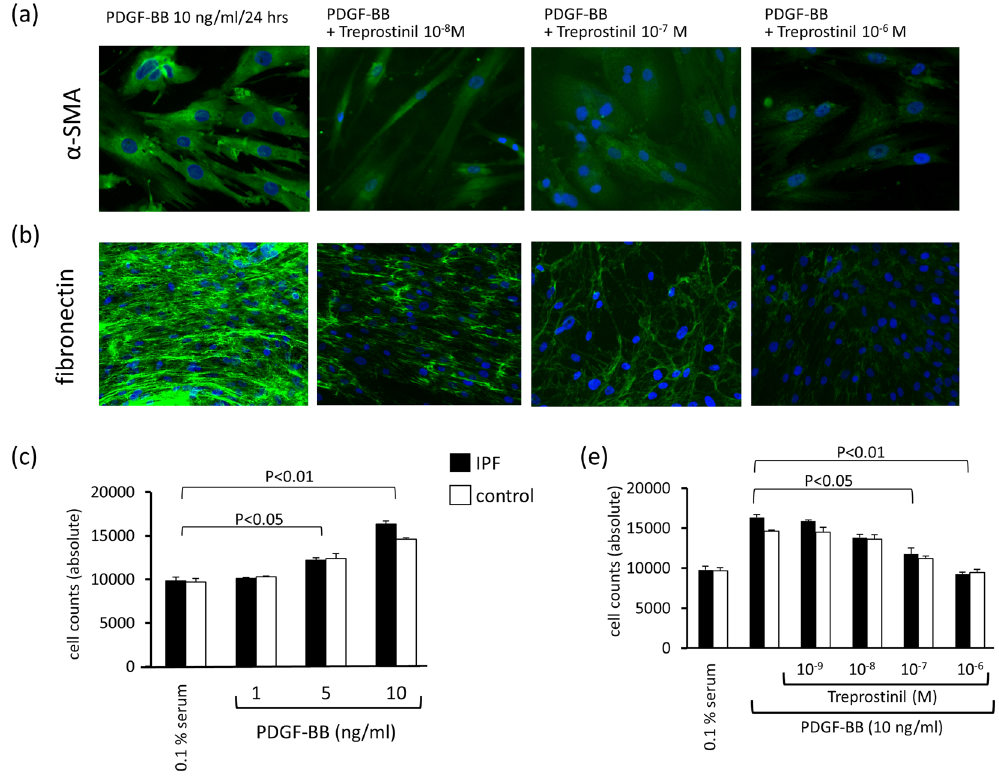
Figure 6. ( a ) Representative cyto-chemical staining (n = 3) for the dose-dependent reduction of PDGF-BB induced expression of α -SMA by Treprostinil at 48 hrs. ( b ) Representative cyto-chemical staining for the dose- dependent reduction of PDGF-BB induced expression of fibronectin (n = 3) by Treprostinil at 48 hrs. ( c ) Dose-dependent stimulation of fibroblast proliferation in three primary human non-fibrotic and three primary human IPF fibroblast lines (3 days). ( d ) Dose-dependent inhibitory effect of Treprostinil on PDGF-BB induced fibroblast proliferation in all primary control and IPF cell lines (3 days). Bars show the mean ± S.E.M. Statistics: Mann-Whitney